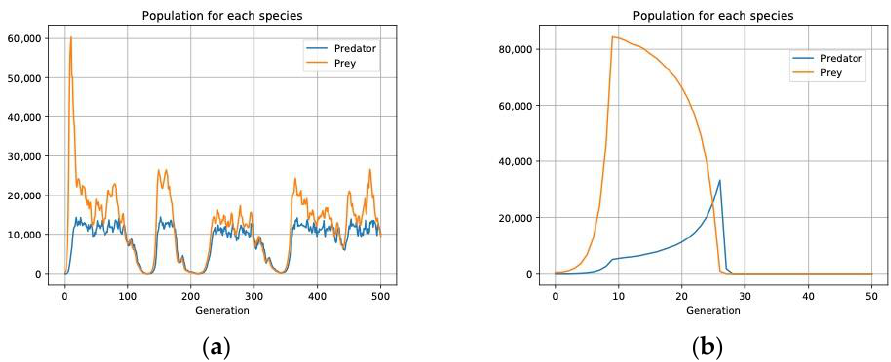
Figure 8. The predator only has offspring if it hunts its prey and kills it. The prey has offspring if it is not hunted. The interaction remains in evolutionary equilibrium if both species have an aggregate distribution ( 100r ) as in ( a ). If the distribution is uniform ( 100n ), as in ( b ) the interaction barely lasts for 30 generations.